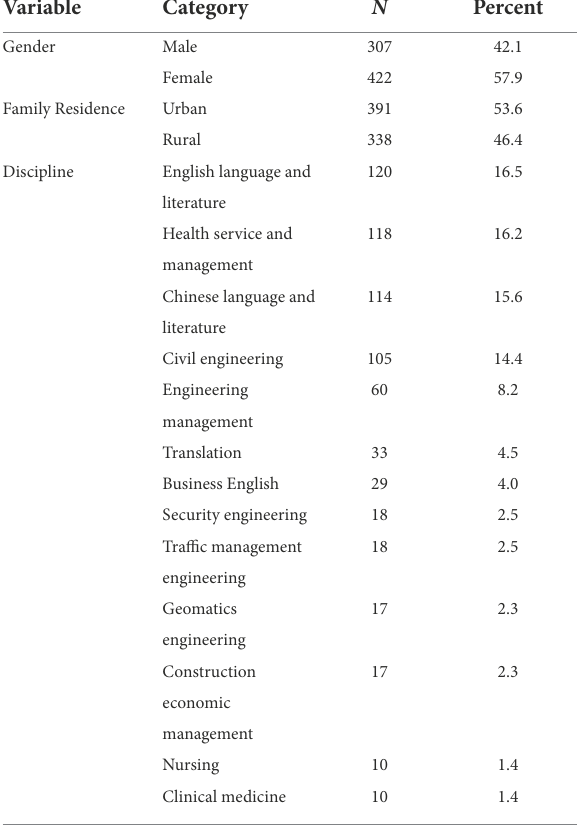
TABLE 1 Basic report of the